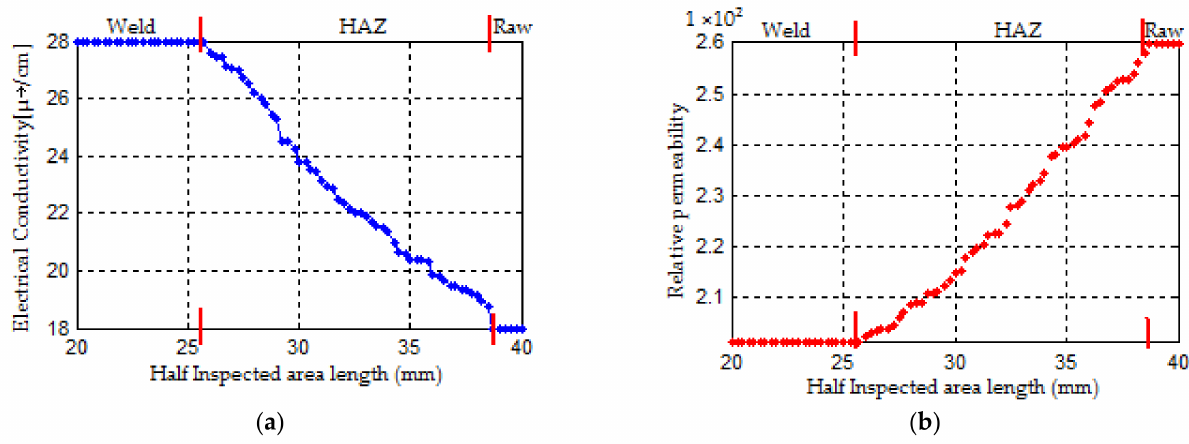
Figure 9. Physical properties distributions: ( a ) Electrical conductivity distribution; ( b ) Relative permeability